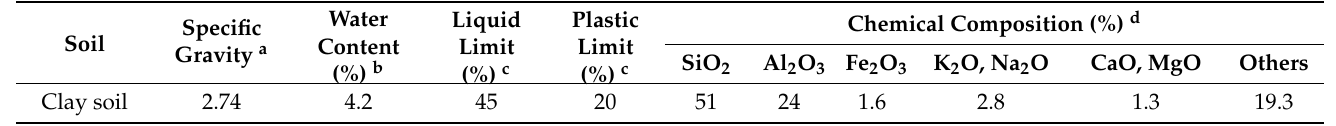
Table 1. Properties of kaolin powder used in the